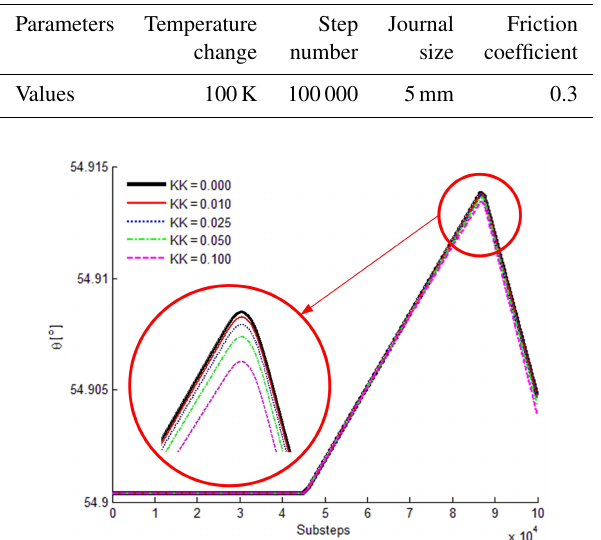
Figure 16. Deflection angle of AB under different elastic coeffi-